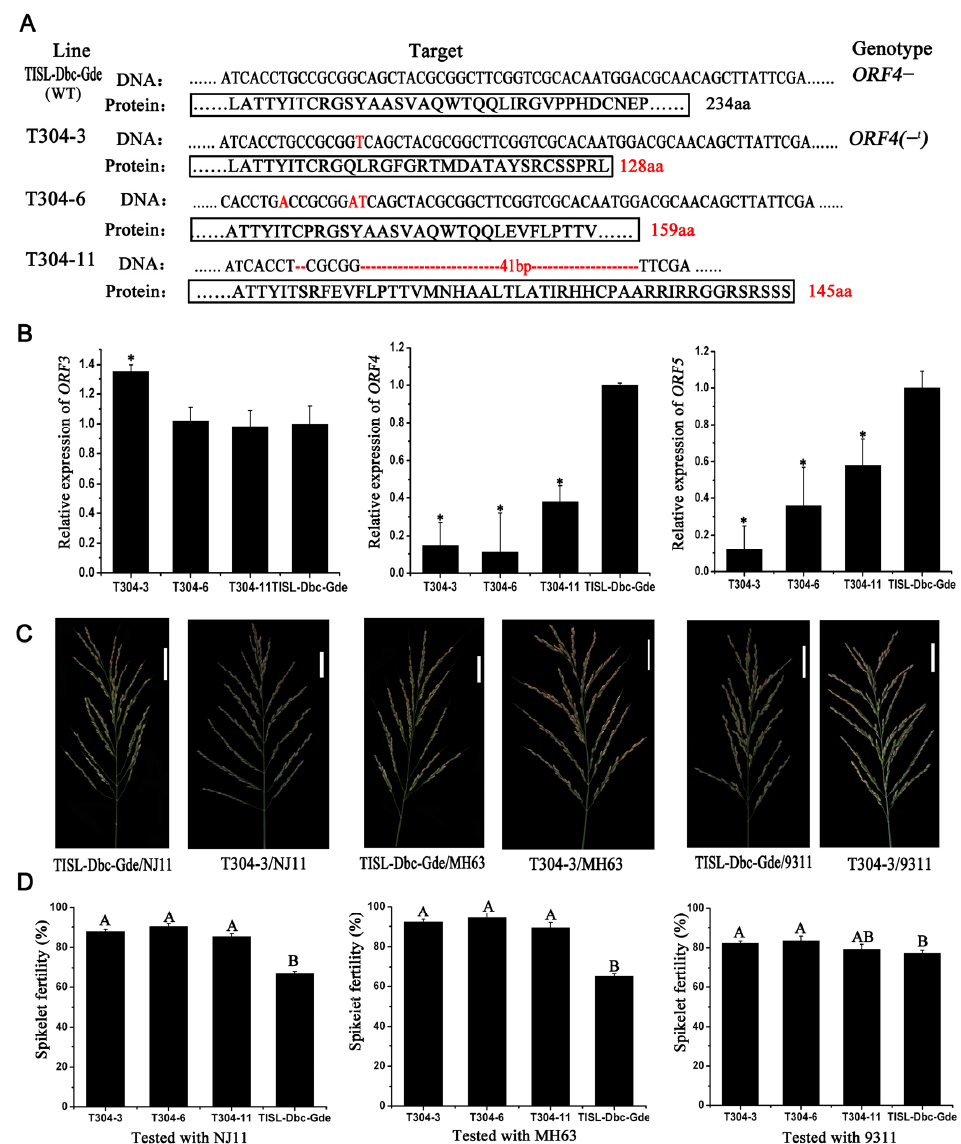
Figure 6. ORF4 knockout overcame the S5 -dependent hybrid sterility in indica / japonica background ( A ) Identification of mutations in ORF4 by sequencing of the target site in T 2 generation. The positions highlighted in red show the targeted mutations and deletions indicated by the red dash “–”. ORF4 ( − t ) indicated the ORF4 gene loss of function. ( B ) qRT-PCR of ORF3 , ORF4 , and ORF5 expression levels in RNA isolated from young panicles of different lines. Profilin was the reference gene. Results were presented relative to the expression level in TISL-Dbc-Gde. * Significantly different at 0.05 probability level. ( C ) Spikelet fertility in the panicles in F 1 hybrids from three crosses. Scale bar in panicles, 1 cm. ( D ) Spikelet fertility in hybrids F 1 from the crosses of TISL-Dbc-Gde with indica testers Minghui63 (MH63), Nanjing11 (NJ11), and 9311. Capital letters indicate statistical differences at 0.01 probability level, n =